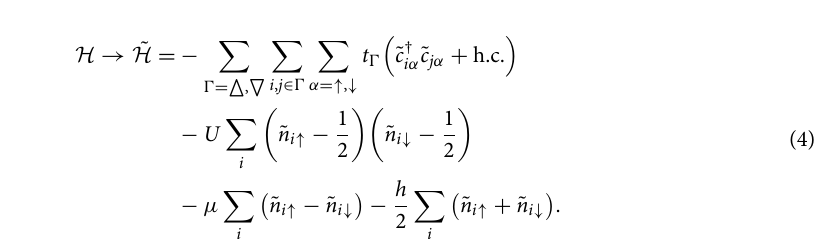
Figure 2. Temperature dependence of ( a ) charge compressibility χ c and ( b ) spin susceptibility χ s at φ = 0.08 for L = 5 under the